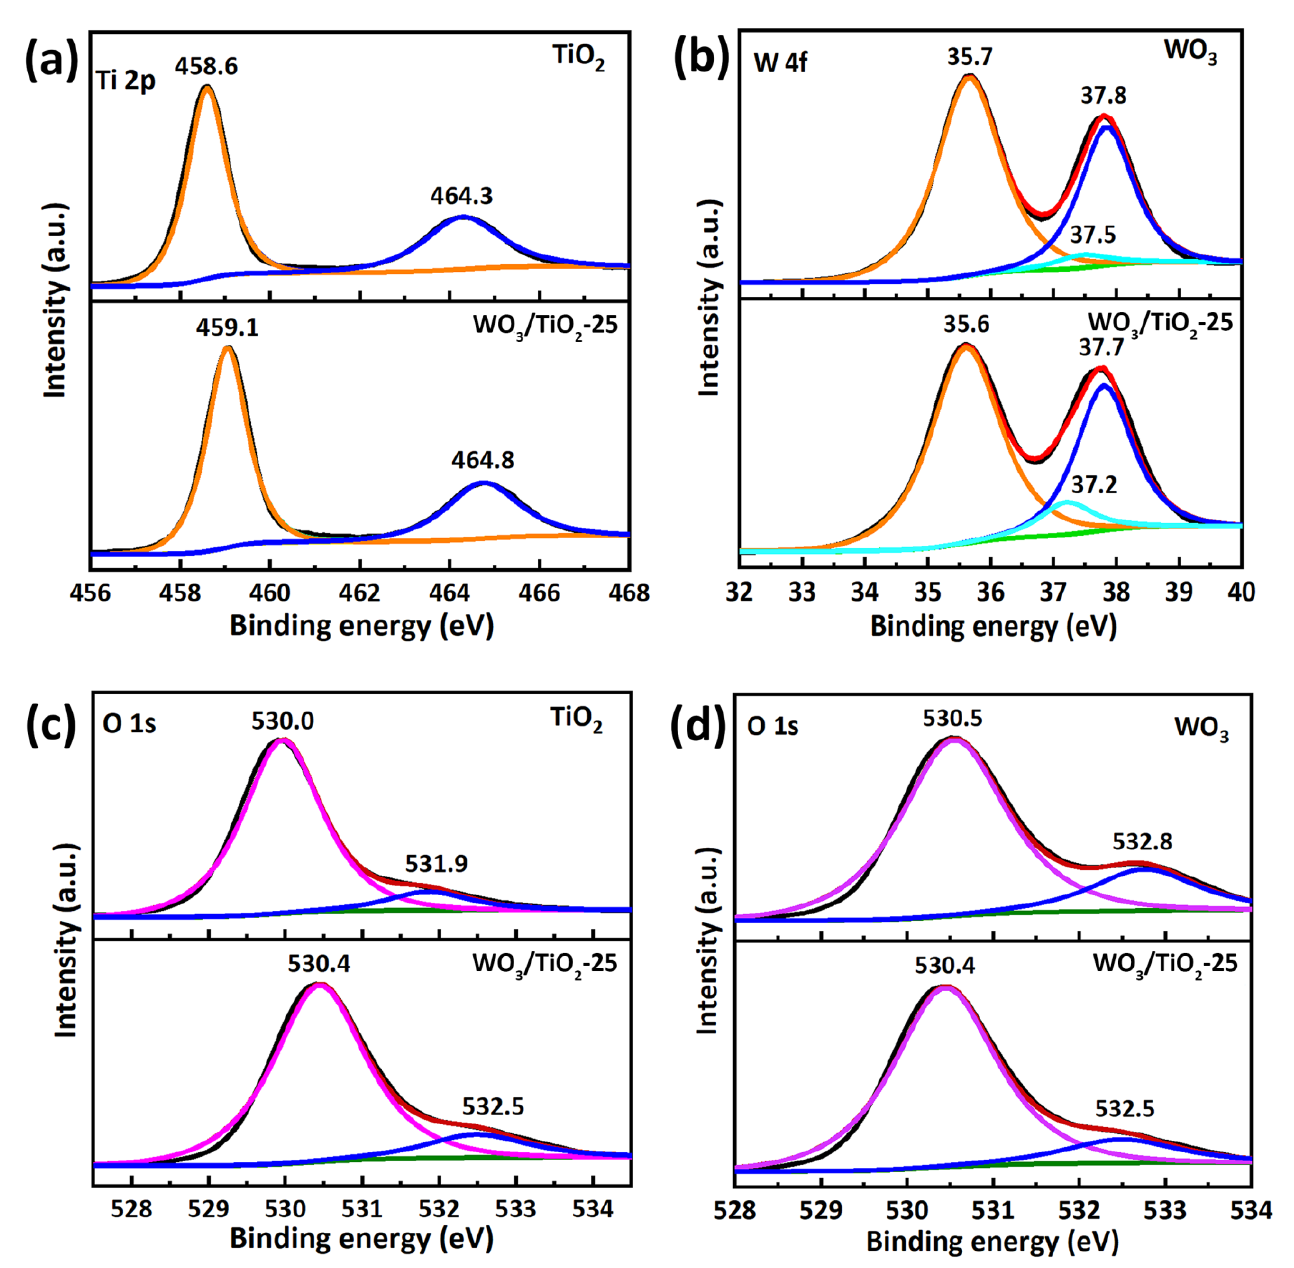
Figure 3. XPS spectra: ( a ) Ti 2p spectra of TiO 2 and WO 3 /TiO 2 -25 heterojunctions. The orange and blue curves are fitting curves corresponding to the Ti 2p 1/2 and Ti 2p 3/2 , respectively. The black line is the raw data. ( b ) W 4f spectra of WO 3 and WO 3 /TiO 2 -25 heterojunctions. The orange, cyan, blue and green curves are fitting curves corresponding to the W 4f 7/2 and W 4f 5/2 , respectively. The black represent the raw data and the red line is the fitting line. ( c ) O 1s spectra of TiO 2 and WO 3 /TiO 2 -25 heterojunctions. The magenta, blue and olive curves are fitting curves corresponding to the Ti-O bond. The black represent the raw data and the red line is the fitting line. ( d ) O 1s spectra of WO 3 and WO 3 /TiO 2 -25 heterojunctions. The magenta, blue and olive curves are fitting curves corre- sponding to the W-O bond. The black represent the raw data and the red line is the fitting line.